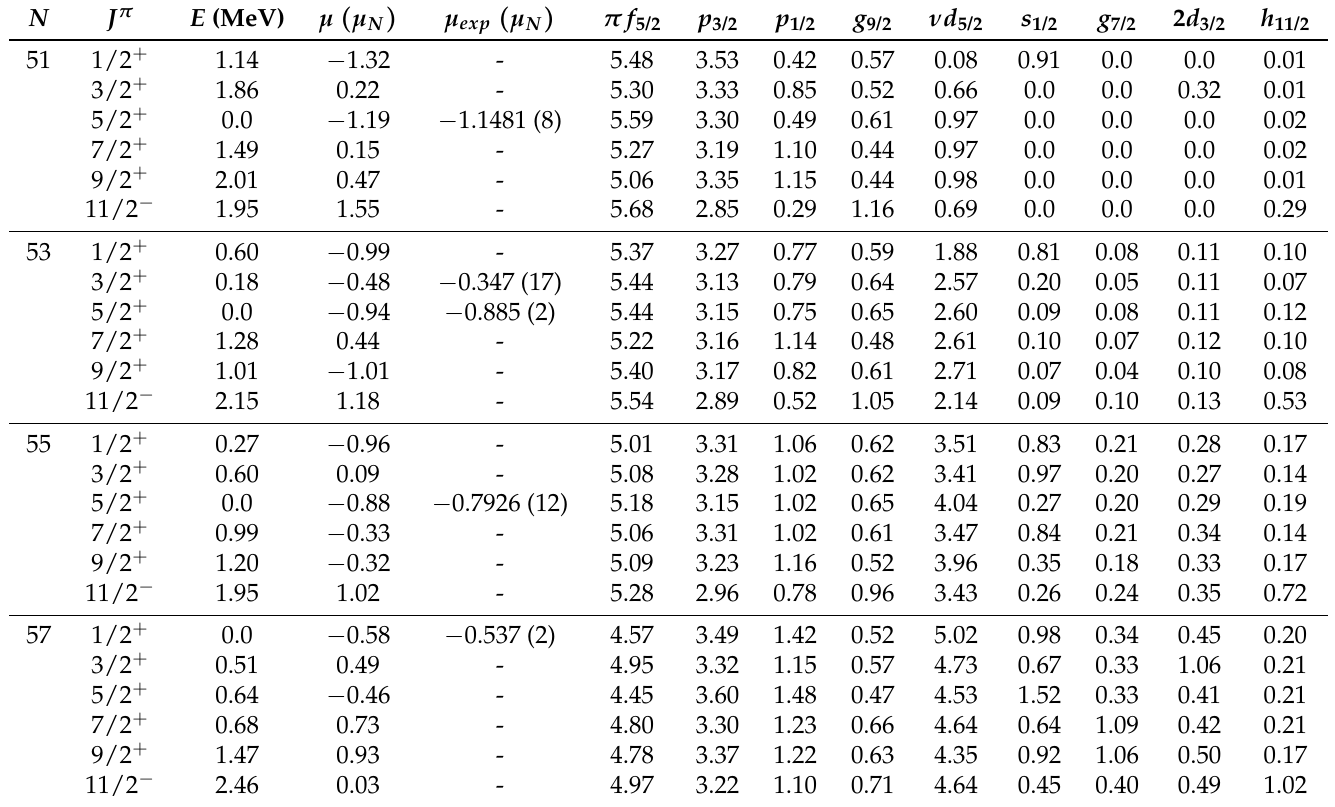
Table 2. Occupation numbers and magnetic moments in selected low-energy states in odd-Sr isotopes. The occupations lower than 0.01 particles are rounded to